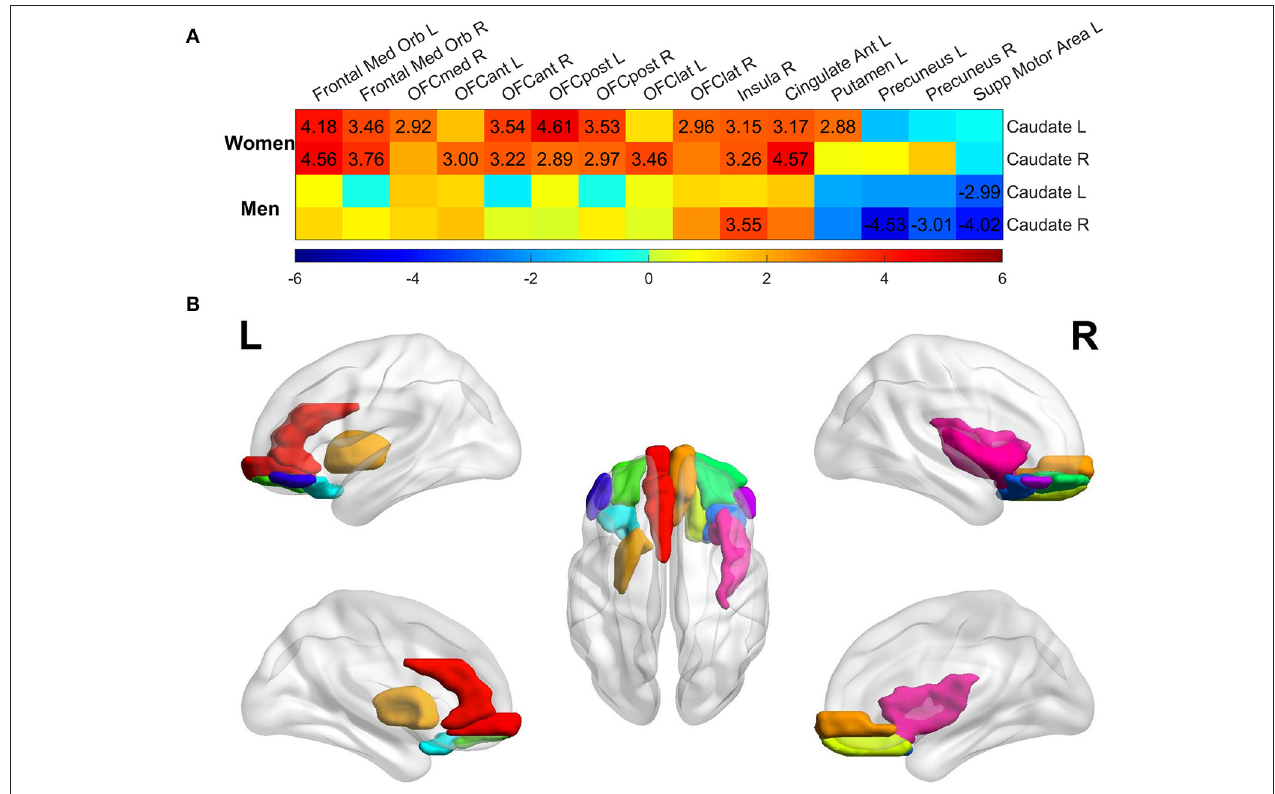
FIGURE 4 | Regional analysis of aging effect on functional connectivity of individual ROI with left/right caudate among the MCI group. (A) t -statistical values of aging effect on functional connectivity of individual region with left/right caudate. All regions were assessed, but only regions having association over the significance threshold p = 0.005 in at least one scenario were listed in the figure. Only the t -values with significance level p < 0.005 were marked in the plot. (B) Brain regions having significant association with age thresholded at p < 0.005 in women with MCI, regardless of the connectivity with left or right caudate.